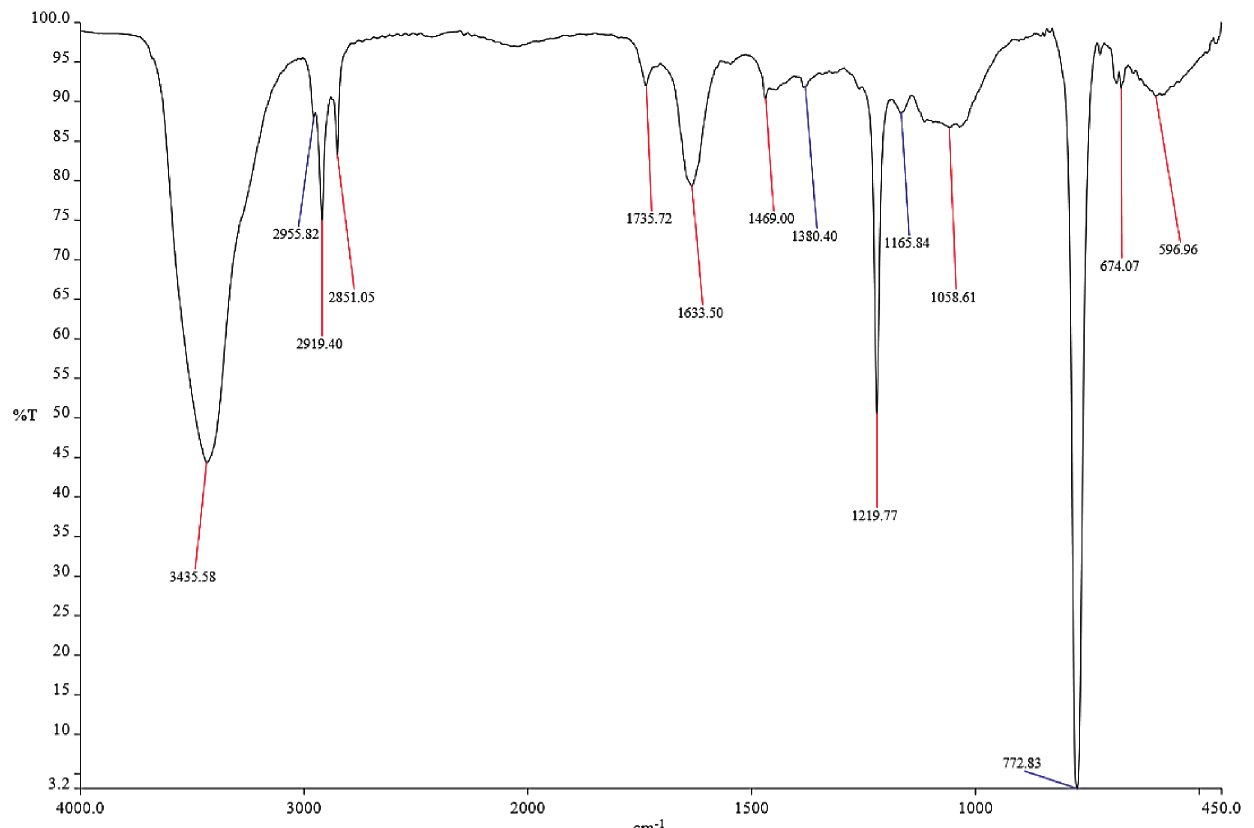
Fig. 5 – FTIR spectrum of the purified biosurfactant produced by Pseudomonas stutzeri